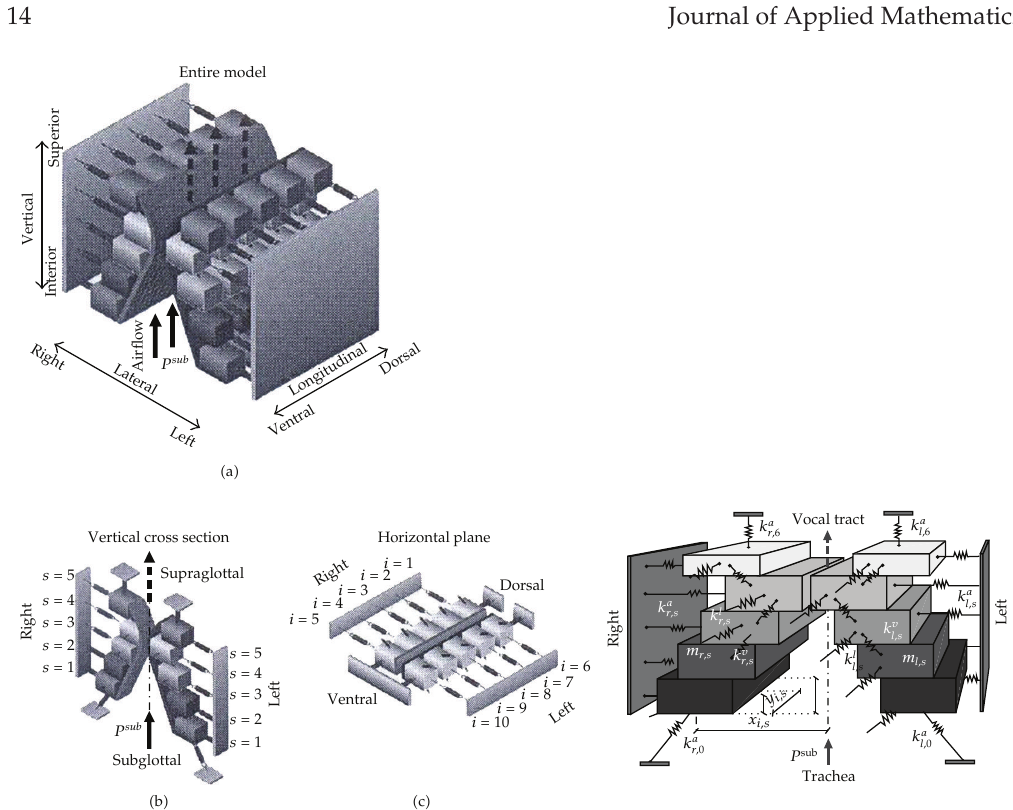
Figure 8: Three-dimensional model of voice folds (cid:4) 50 (cid:5)